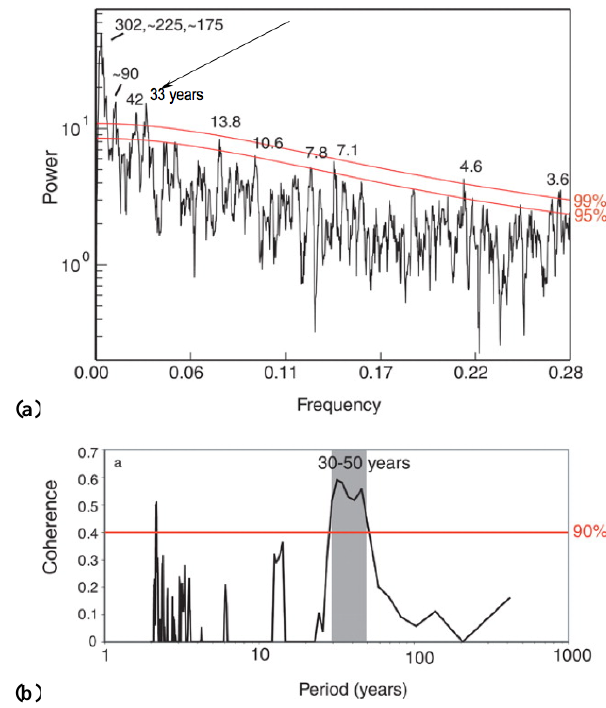
Figure 2. (a) Multi-taper method (MTM) spectral analysis of the X-ray fluoroscopy data gauging sediments in the African lake Bo- sumtwi (Shanahan et al. 2009). Significant power is apparent on interannual (3.6- to 4.6-year), decadal (7.1-, 7.8-, 10.6-, and 13.8- year), multidecadal (33- to 42-year), and century (90-, 175-, 225-. and 302-year) time scales. For clarity, only the portion of the power spectra > 3.57 years ( F = 0.28) is shown. The oblique lines denote the 99 to 95% confidence interval. MTM analyses were performed with the program k-spectra. Parameters p = 3, K = 5, and a null hy- pothesis of red noise were used in the analysis. Labeled are periods (in years) for peaks that are significant at 95%. Note the prominent spectral peak protruding above the 1% level of statistical signifi- cance with a period of 33 years (arrow) corresponding to a BEL. (b) Cross-spectral coherence computed for Lake Bosumtwi (600- year detrended first principal component [PC1] of the full suite of elemental data [aluminum, Al; silicon, Si; potassium, K; titanium, Ti; manganese, Mn; and iron, Fe]) and the Atlantic multidecadal oscillation reconstruction. The horizontal line indicates the 90% confidence interval. The records are in phase and highly coherent at a period of 30 to 50 years (indicated by gray shading). Reproduced from Shanahan et al. (2009) with kind